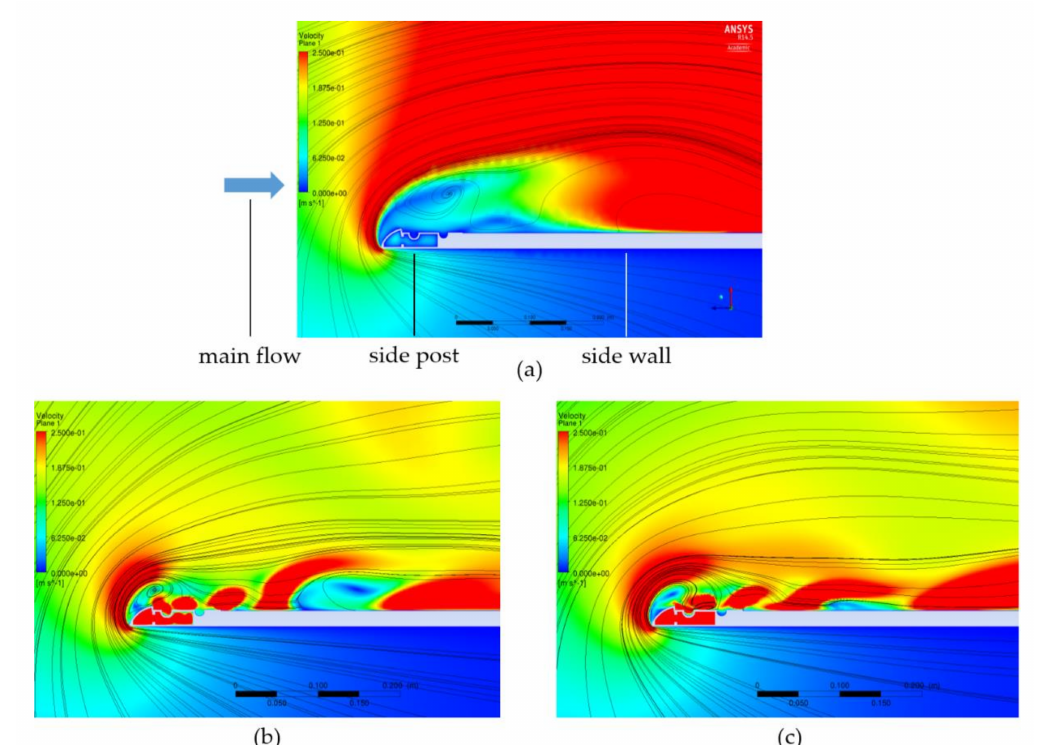
Figure 12. Flow in the area of side post and side wall. Diagrams with sectional streamlines of the mean flow field in a horizontal level and contours of the three-dimensional velocity magnitude normalized by the mean inflow velocity: . . S = 14.1 m 3 /h); and ( c ) oscillating wall jets ( S = 6.8 m 3 ( a ) without wall jets; ( b ) steady wall jets (